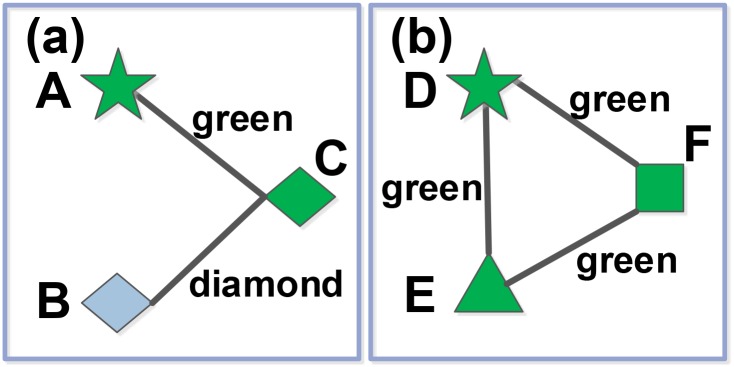
Illustration of similarity redundancy.A, B, D and E are collected objects, and C and F are the uncollected. Object pairs (A, C) and (B, C) respectively have similarities of color green and geometry diamond. So there is no similarity redundancy between A and B. However, (D, F) and (E, F) both have the similarity of color green so that D and E possess the similarity redundancy of color green.